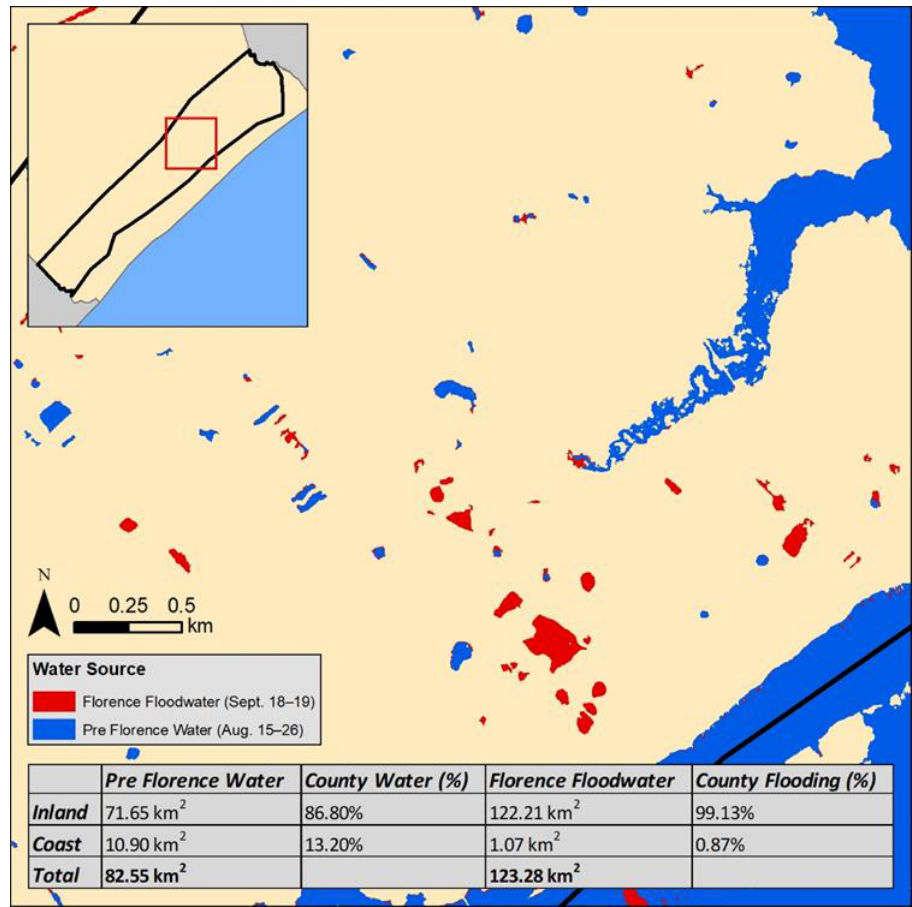
Figure 6. Hurricane Florence (September 2018) caused extensive inland flooding (122 km 2 ), but much less flooding (only 1.07 km 2 or less than 1%) along the coast.